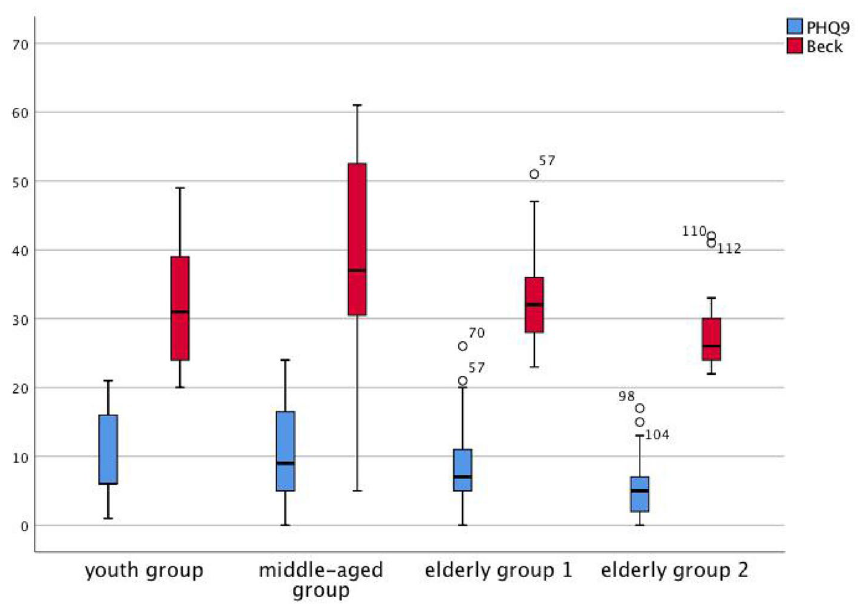
Figure 5. Box plots of PHQ-9 and Beck score in each